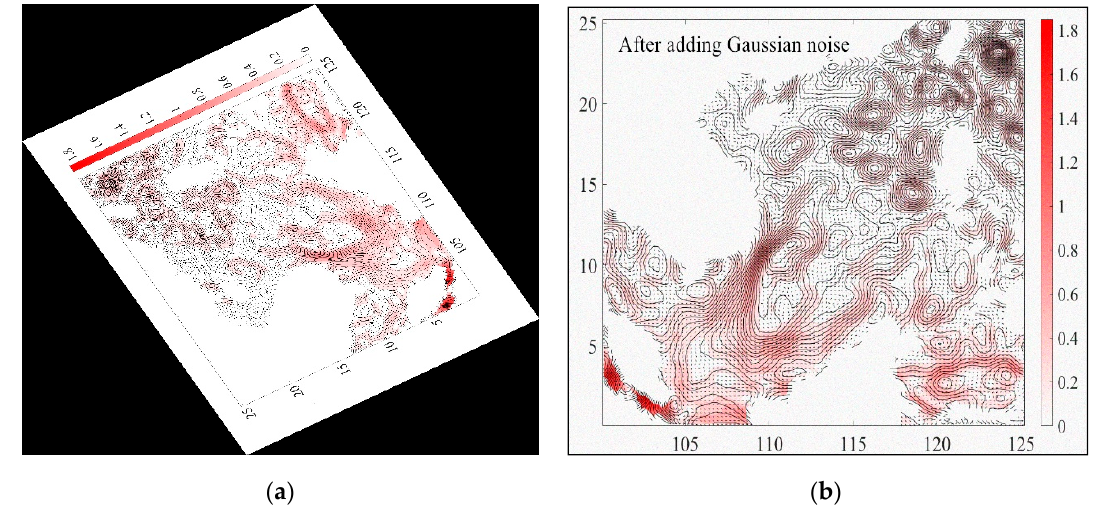
Figure 3. ( a ) An example of the original image rotation by 120°. ( b ) The SLA contour map after adding Gaussian noise. Color map and contours (black lines) represent the geostrophic velocity speed [m/s] (Equation (1)) and sea level anomaly [cm] respectively.